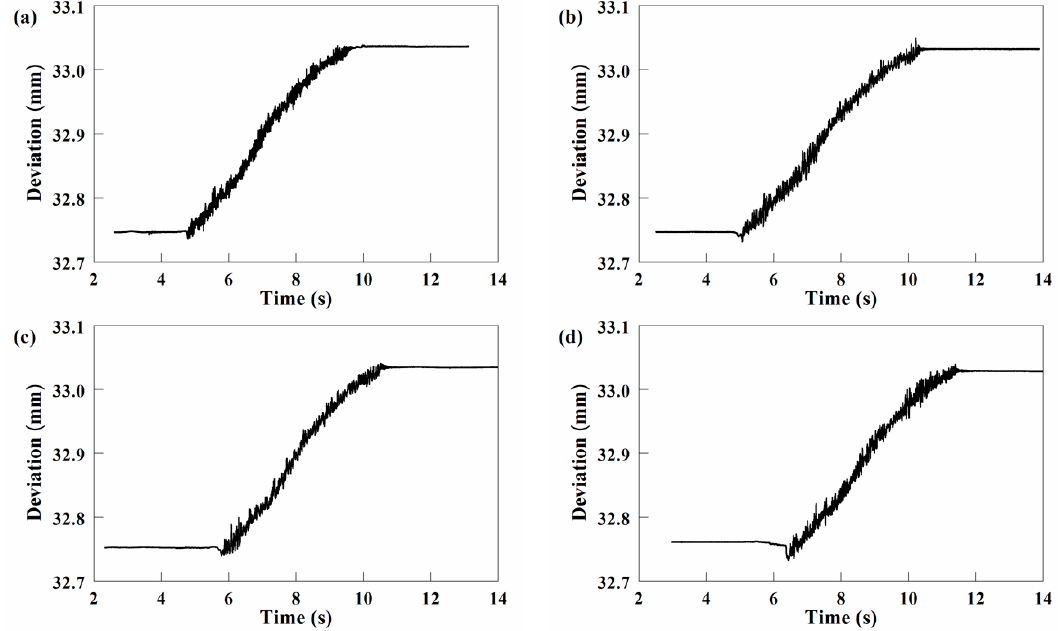
Figure 16. The measurements when PB is the measured surface ( a ) measurements 1 ( b ) measurements 2 ( c ) measurements 3 ( d ) measurements 4.